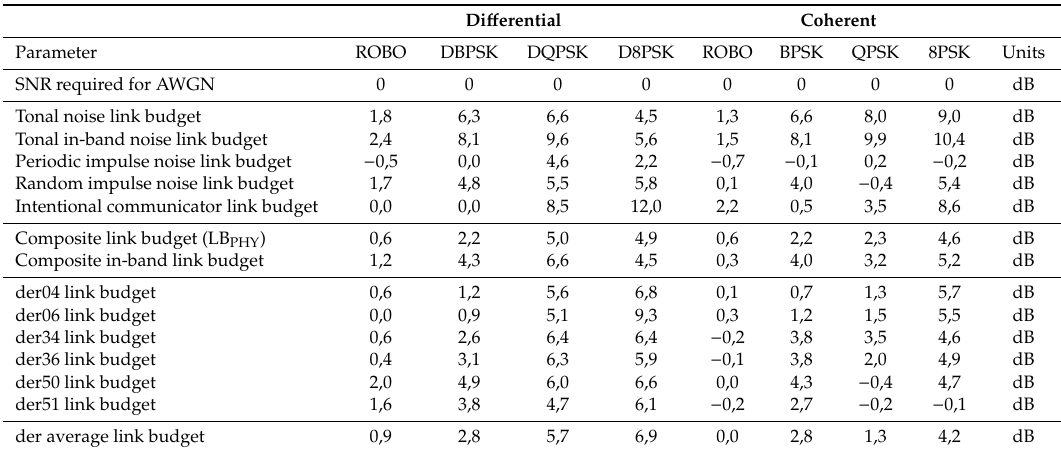
Table 10. Incremental results with the standard tone map implemented in G3-PLC compared to the original implementation presented in